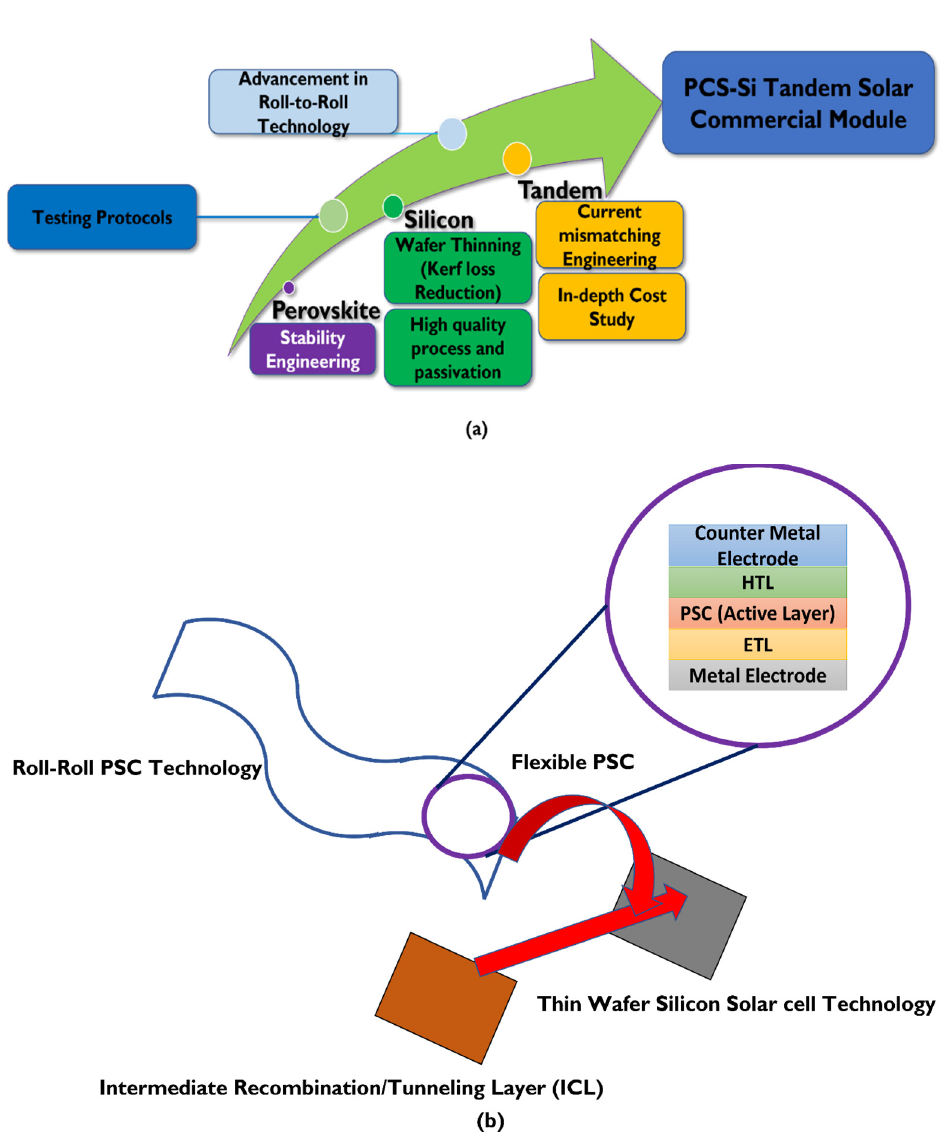
Figure 7. Schematic diagram of ( a ) A way forward towards PCS-Si tandem vast industrialization and the work required Table 2. T- PSC-Si based on roll-roll technology integration with existing silicon solar cell technology as part of the overall roadmap in ( b ).